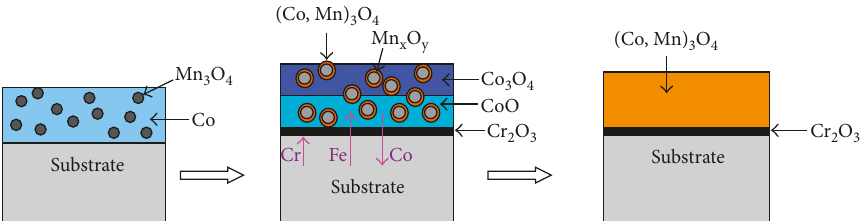
Figure 7: Sketches illustrating the process of thermal conversion of the Co-Mn